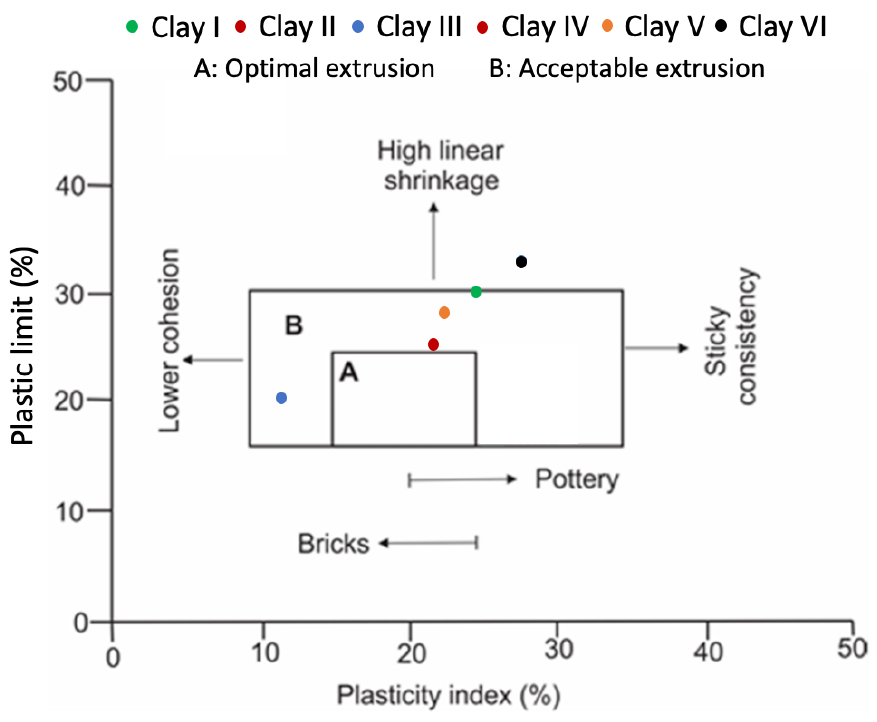
Figure 13. Extrusion prognostic (or workability chart) of clays studied via index properties.